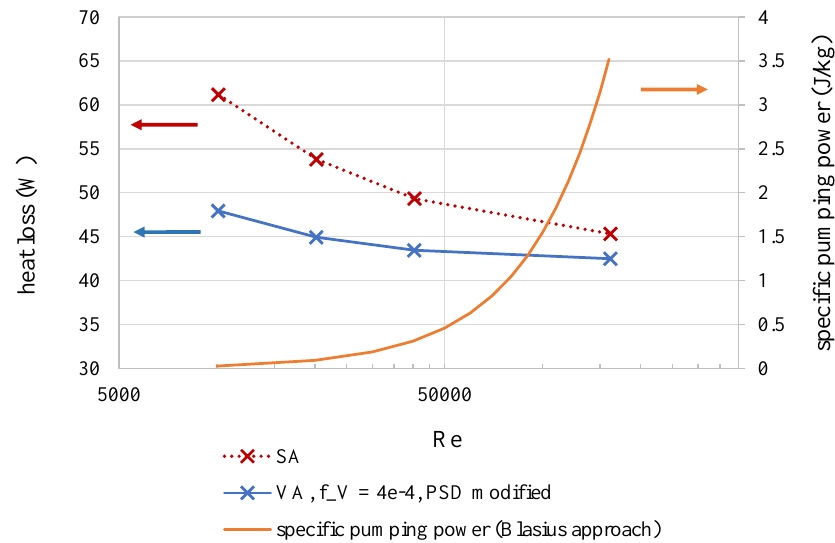
Figure 4. High Reynolds numbers are required in the surface absorber to lower the heat loss. This dependency is weaker in volumetric absorber systems. Additionally, the specific pumping power is shown using the Blasius approach for the pressure loss coefficient. Flows at lower Reynolds numbers require significantly less pumping